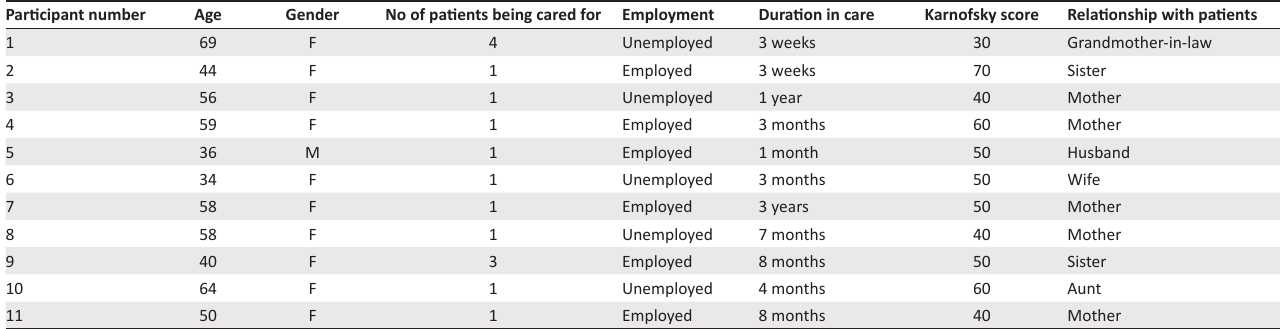
TABLE 1: Demographic data of participants. Participant